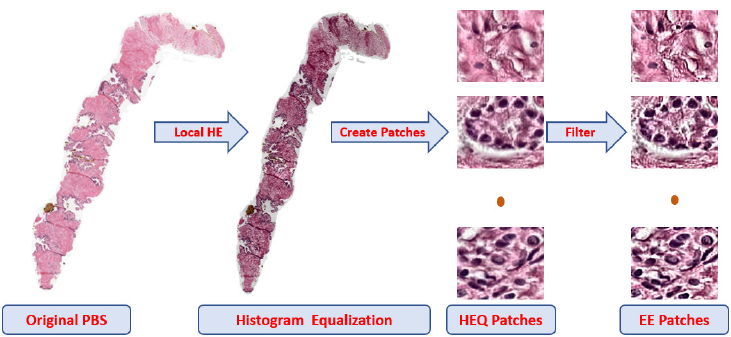
Figure 3. Preprocessing steps: PBSs are the digitized prostate biopsy specimens, HEQ is histogram equalization, and EE is edge